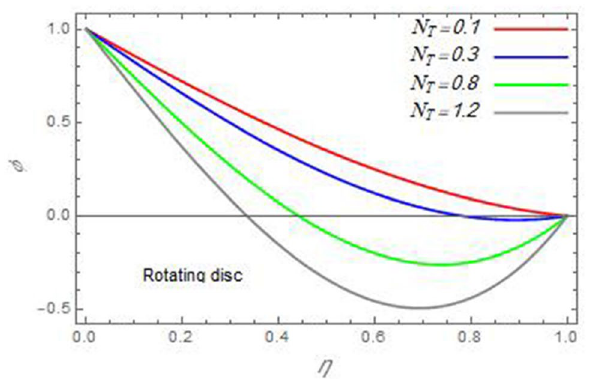
Figure 26. The nanoparticles volume fraction distribution ϕ is plotted versus the axial variable η in the case of stationary cone to depict the effect of the thermophoresis parameter N T .